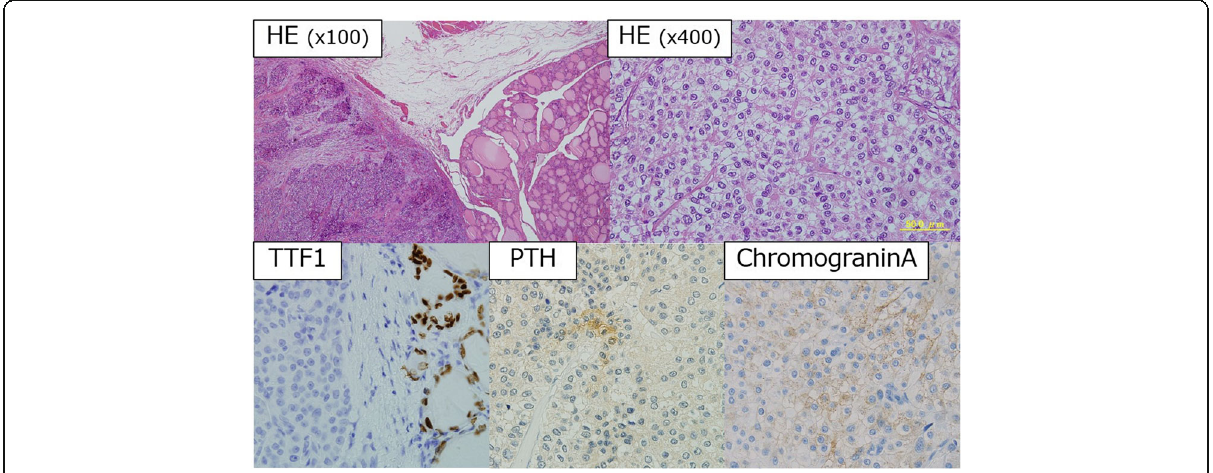
Fig. 5 Pathological findings. A solid tumor with broad fibrosis invading surrounding tissues was observed under ×100 field, and atypical cells containing oval and clear cytoplasm were observed under ×400 field. The cytoplasm was slightly stained for PTH and